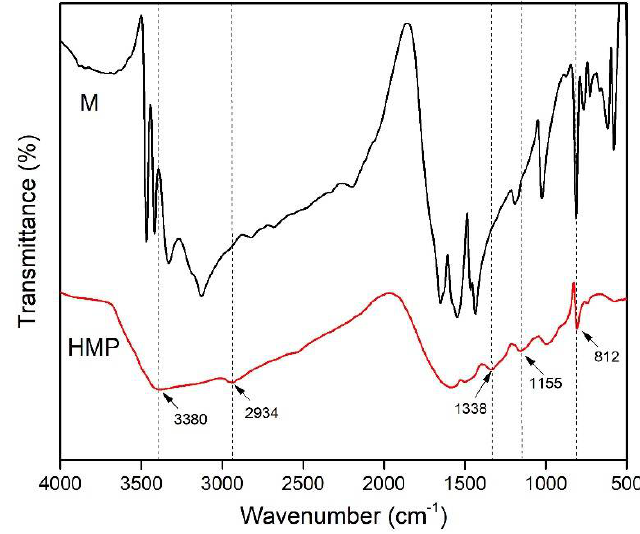
Figure 2. FTIR spectra of M and HMP.